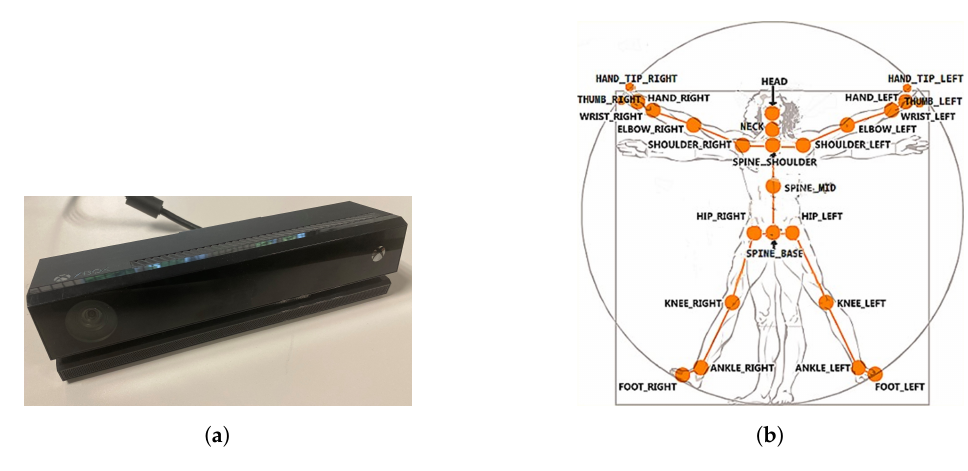
Figure 2. Kinect V2: ( a ) general view; ( b ) recognizable body